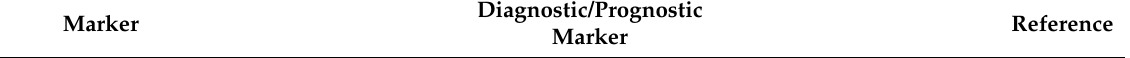
Table 1. Highlights of CSC biomarkers and their implications in diagnosis and prognosis of